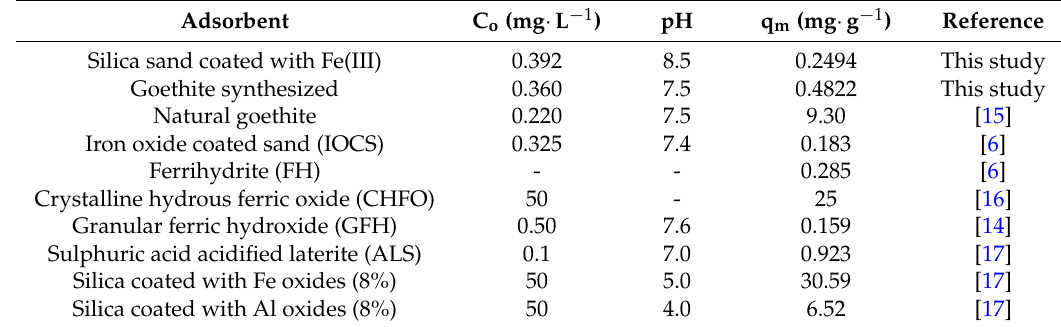
Table 7. A comparison of the produced materials’ As(V) sorption capacity (q m ) with data from the literature, and the best fit Langmuir isotherm model.